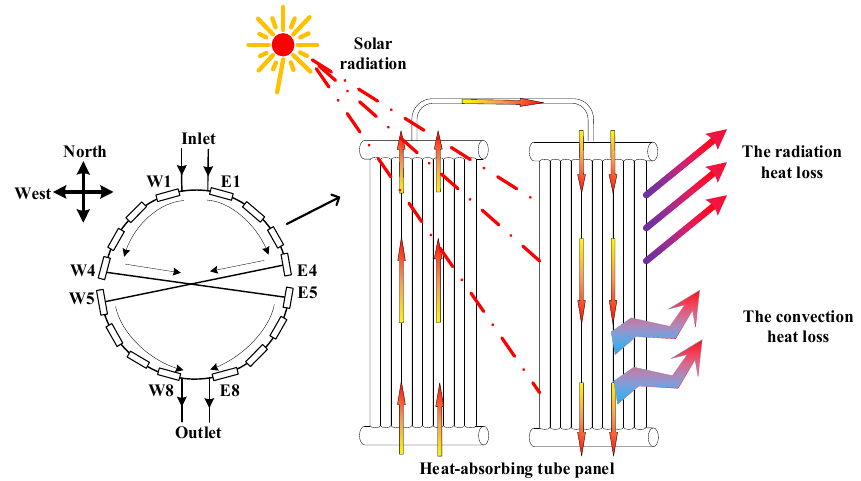
Figure 3. The flow path of the molten salt and the heat transfer process of the tube panel.